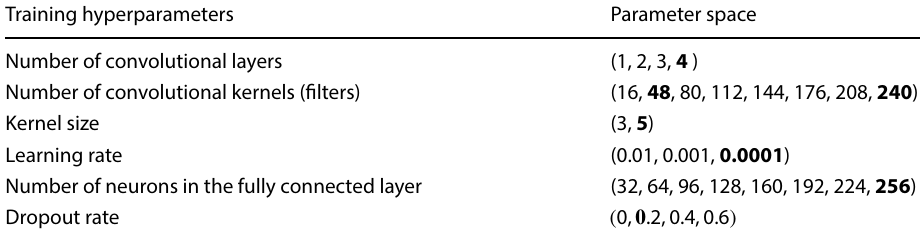
Table 2 Potential hyperparameters and the potential search space used in this work during the hyperparameter selection